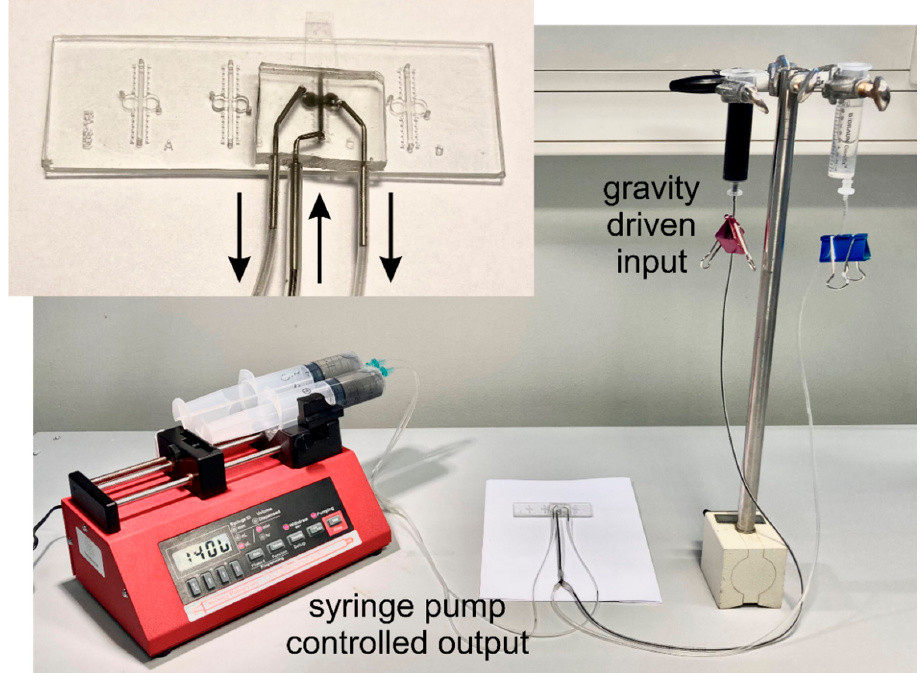
Figure A2. Chip-based setup. Solution input was driven by gravity, solution output was precisely controlled by microfluidic syringe pump with two syringes individually connected to two cell compartments. Close up panel demonstrates microfluidic chip in assembly with chip insert. Arrows show direction of solution flow.